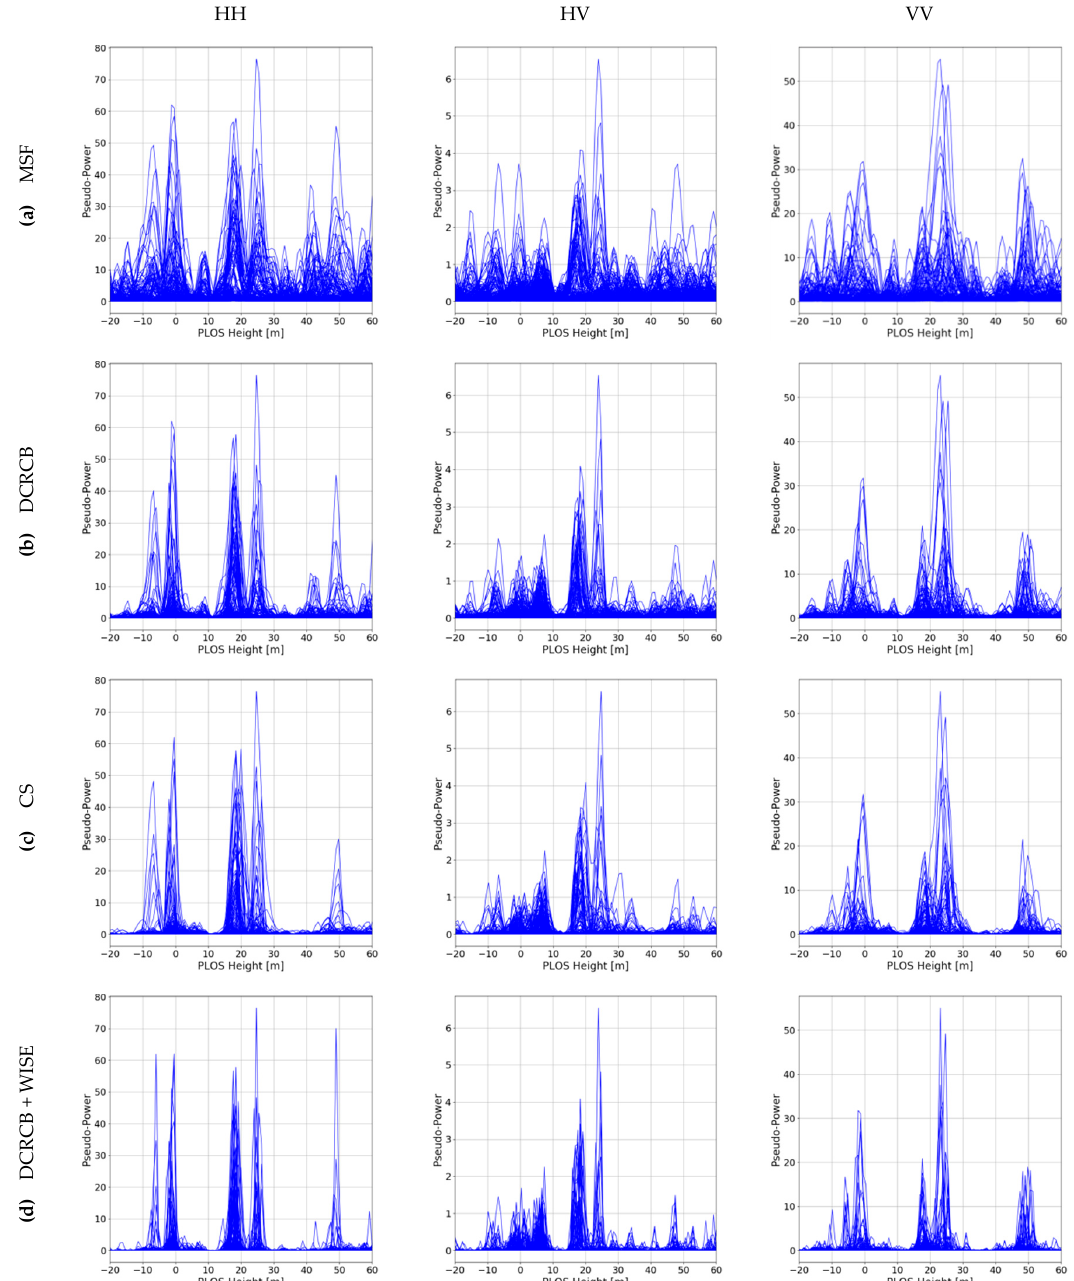
Figure 18. Two hundred and forty-two superimposed vertical profiles spanning about 194 m along azimuth with a 1.2° slope, taken from the tomograms displayed in Figures 15–17: ( a ) MSF, ( b ) DCRCB, ( c ) CS and ( d ) DCRCB + WISE. From left to right: HH, HV and VV. The (pseudo) power is presented in a linear scale.